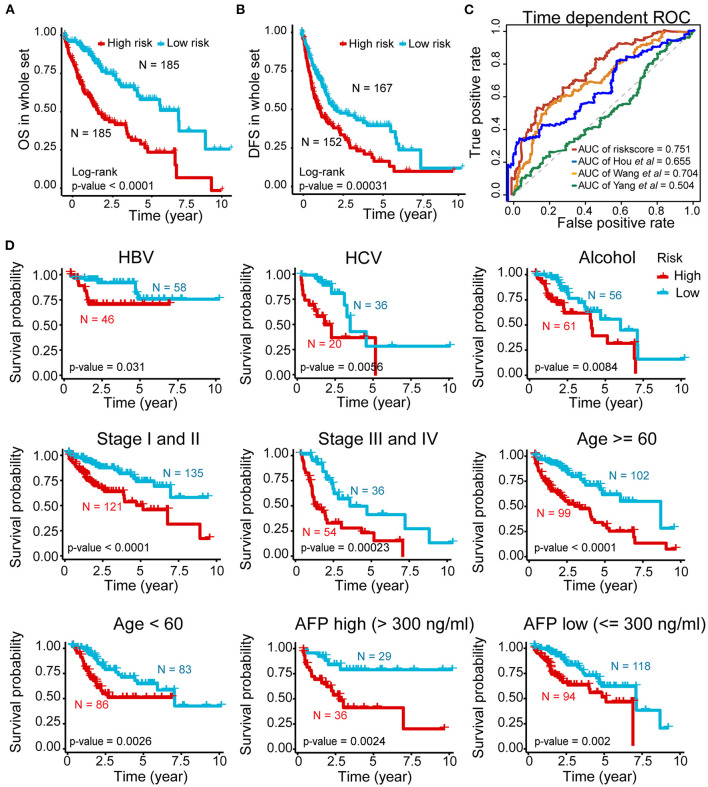
Prognostic power of the five-AR-lncRNA prognostic signature in stratification analysis. (A) Kaplan–Meier survival curve for the high- and low-risk groups divided by the cutoff value in the whole set. (B) Disease-free survival (DFS) for the high- and low-risk patients. (C) The ROC analysis of OS outcomes for the five-AR-lncRNA signature (TMCC1-AS1, PLBD1-AS1, MKLN1-AS, LINC01063, CYTOR) by us; five-autophagy-related gene (ARG) signature (HDAC1, RHEB, ATIC, SPNS1, and SQSTM1) by Huo et al. (2020); four-lncRNA signature (ENSG00000234608, ENSG00000242086, ENSG00000273032, ENSG00000228463) by Yang et al. (2020) and four-lncRNA signature (RP11-322E11.5, RP11-150O12.3, AC093609.1, CTC-297N7.9) by Wang et al. (2017) (D) Kaplan–Meier curves of patients stratified by different clinicopathological traits. Hepatitis B virus, HBV; hepatitis C virus, HCV. p-values were obtained via log-rank test.